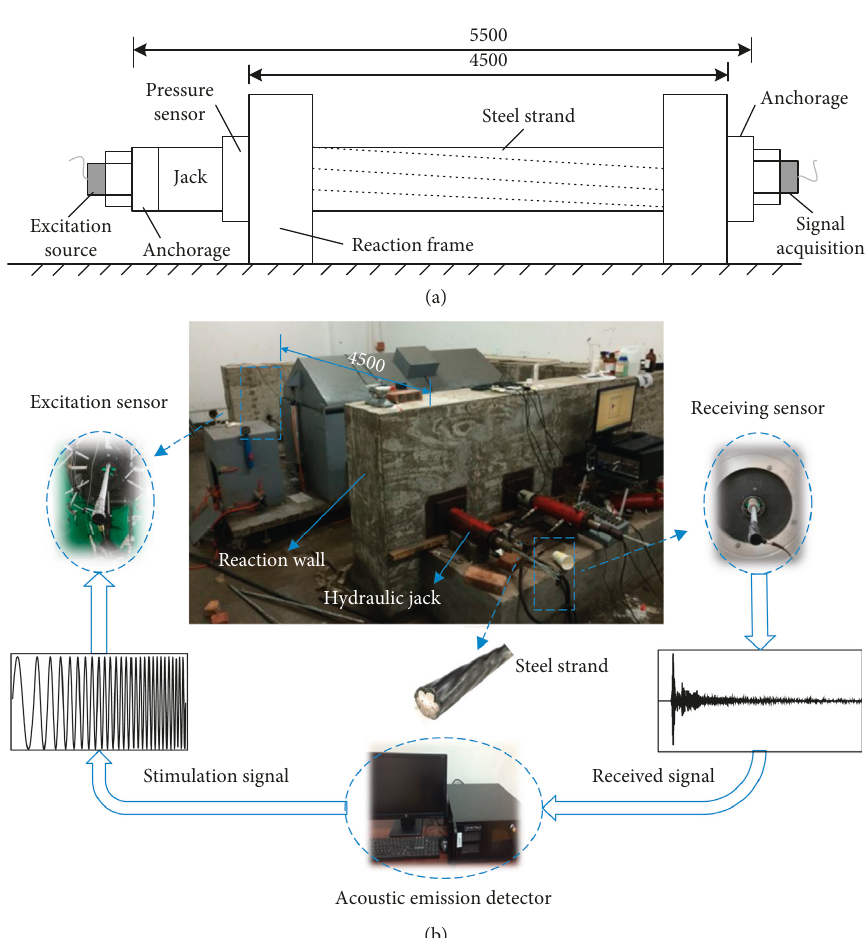
Figure 8: Design of the experiment system (unit: mm). (a) Layout of the experiment system. (b) Equipment of the system.